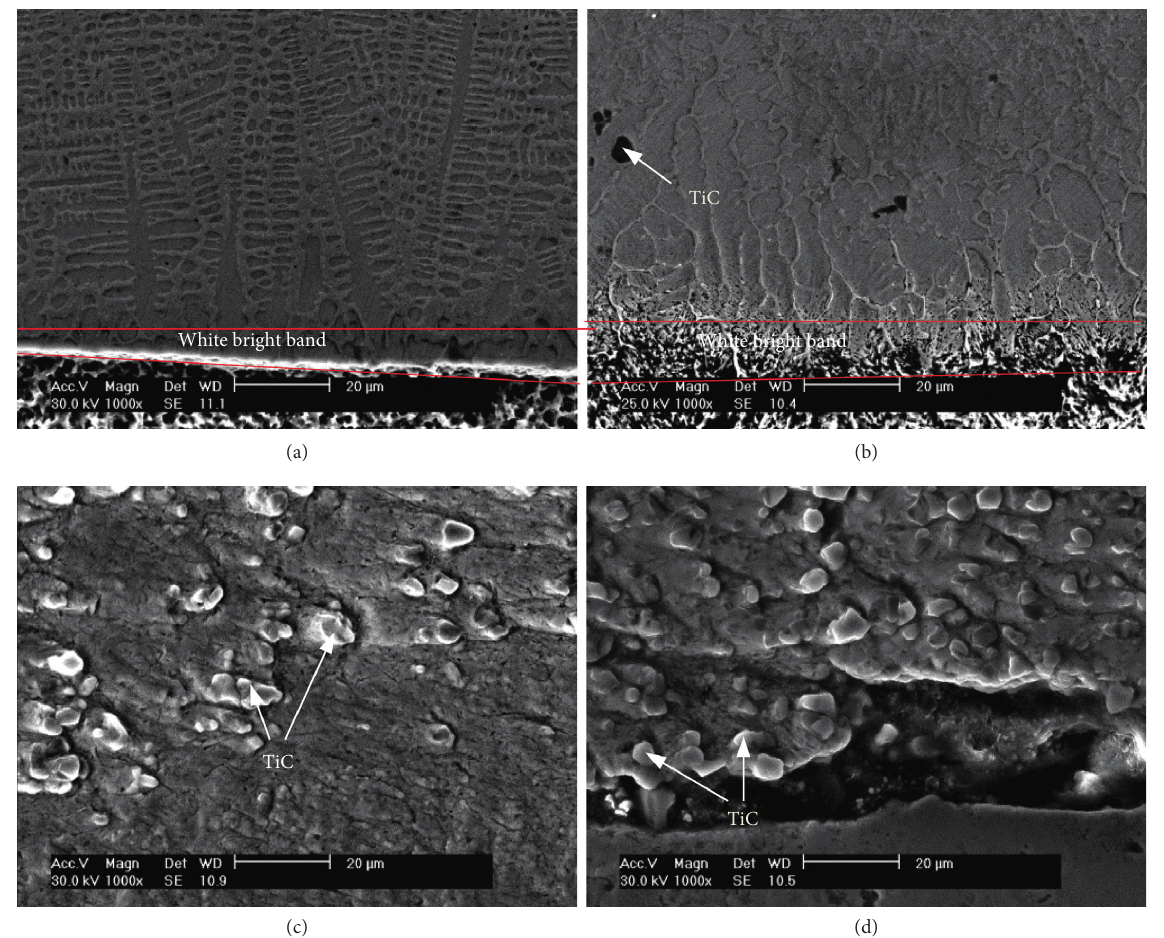
Figure 7: Microstructure of the cross section of the coatings after the laser cladding process. (a) A coating, (b) B coating, (c) C coating, and (d) D